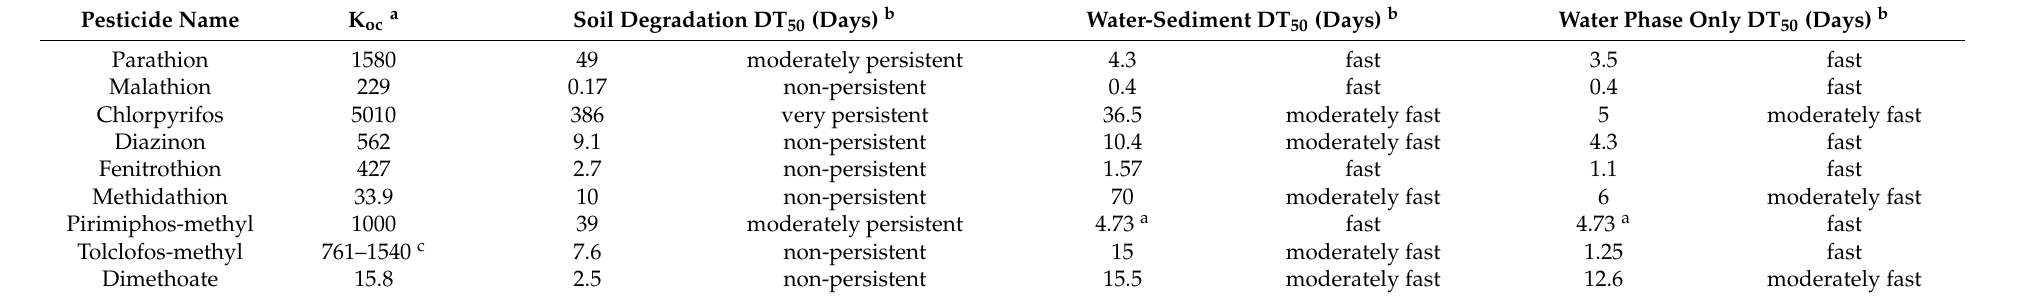
Table 5. Soil organic carbon partition coefficient (mL g − 1 ) (K oc ), soil degradation DT 50 (days), water-sediment DT 50 (days), water phase only DT 50 (days) of the detected